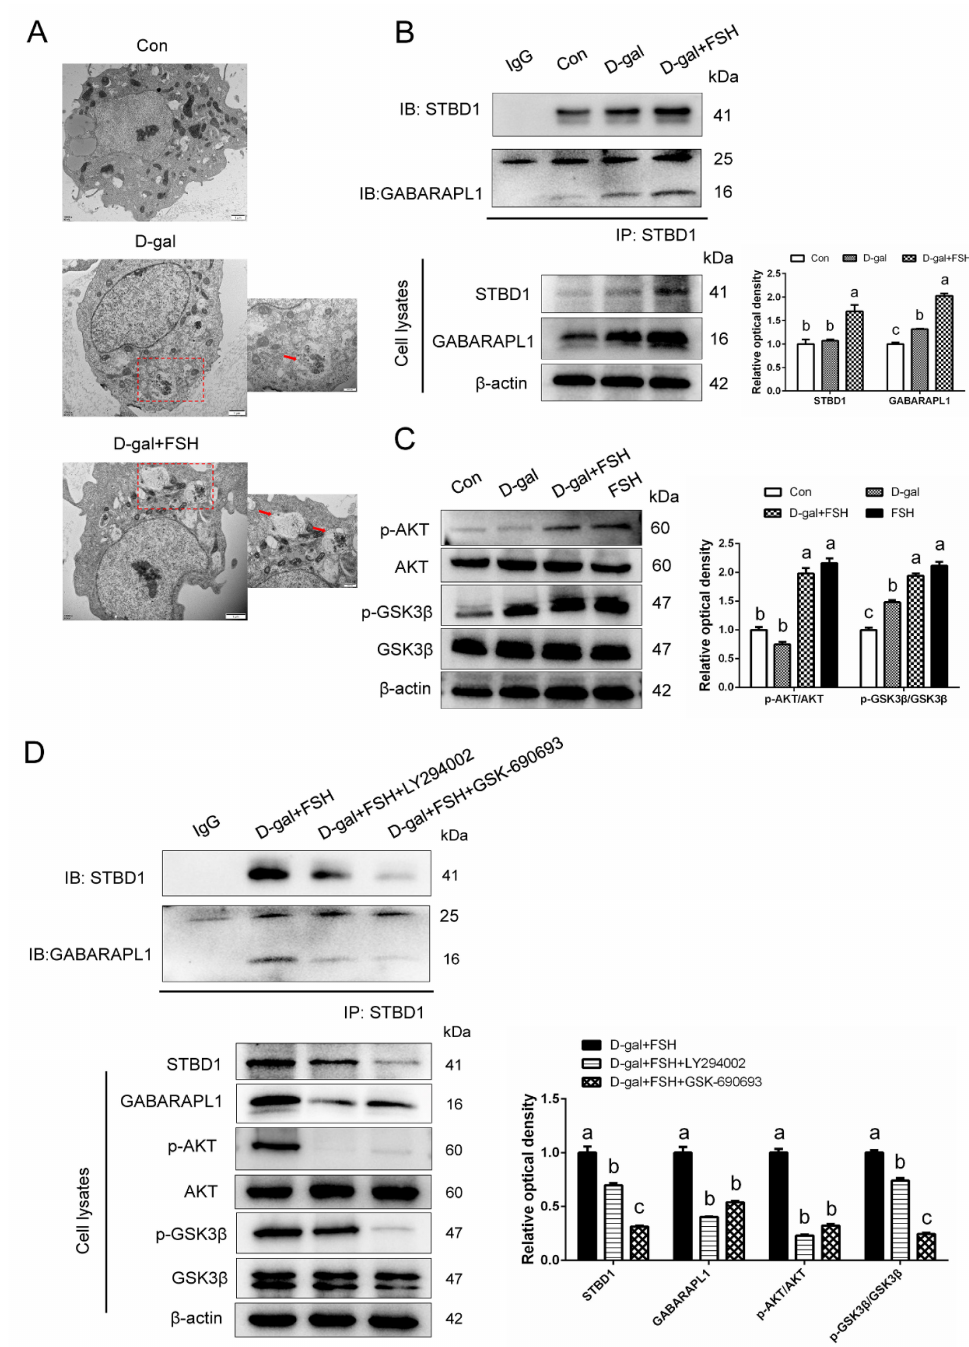
Figure 6. Phosphoinositide 3-kinase (PI3K)/AKT signaling is involved in FSH-induced glycophagy in D-gal-induced senescent GCs. ( A ) Electron micrograph of glycophagosomes (red arrows) in senescent GCs with FSH treatment. The box indicates the area enlarged on the lower right. Scale bars: 1 µ m, 500 nm. ( B ) Isolated GCs in the control, D-gal, and D-gal + FSH groups were collected and then immunoprecipitated with STBD1 antibody. STBD1 and GABARAPL1 expression in cell lysates was examined using anti-STBD1 and anti- GABARAPL1 antibodies. ( C ) Western blot and quantitative analysis of AKT and GS3K β phosphorylation in the control, D-gal, D-gal + FSH, and FSH alone groups. ( D ) Co-immunoprecipitation of STBD1 and GABARAPL1 in senescent GCs treated with FSH, FSH + PI3K inhibitor LY294002, or FSH + AKT inhibitor GSK690693. The expression levels of AKT and GS3K β in cell lysates were also verified. Different lowercase letters present significant differences ( p <